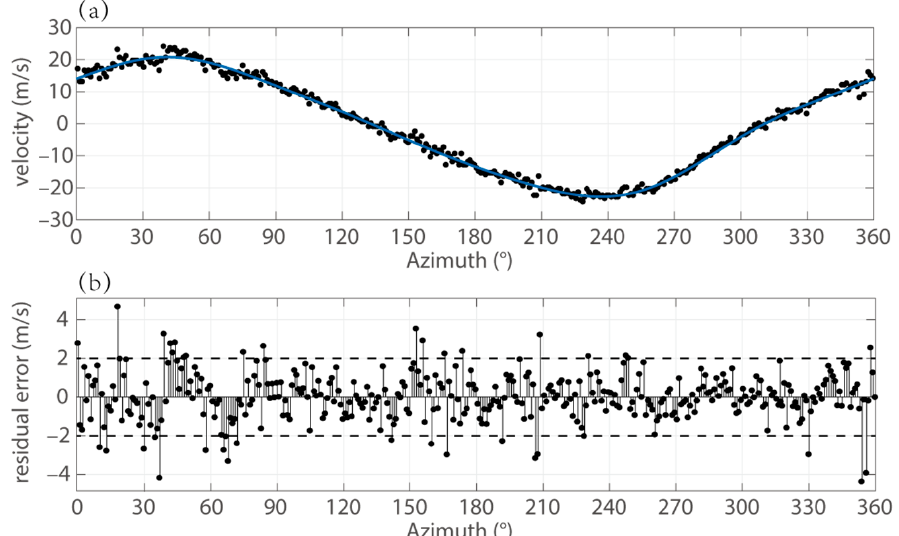
Figure 5. ( a ) An example of VAD data from the CINRAD/SA in Beijing. The line is the modeled radial velocities as a sine function of the azimuth, and the dots are the data of the Doppler velocity. The data samples are in the range of 30 km and the elevation of 2.4 deg. ( b ) The residual error (the dot) is essentially less than 2 m/s. The root mean squared error is 1.278, and the adjusted R-square is 0.9924.